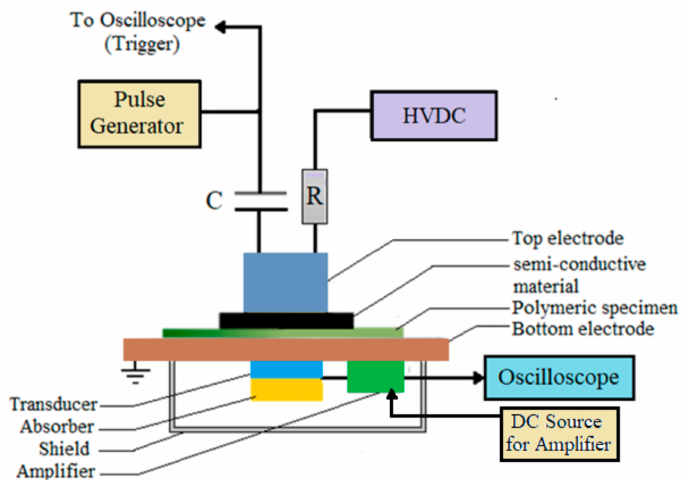
Figure 3. Pulsed electro acoustic (PEA) experimental setup of space charge measurement